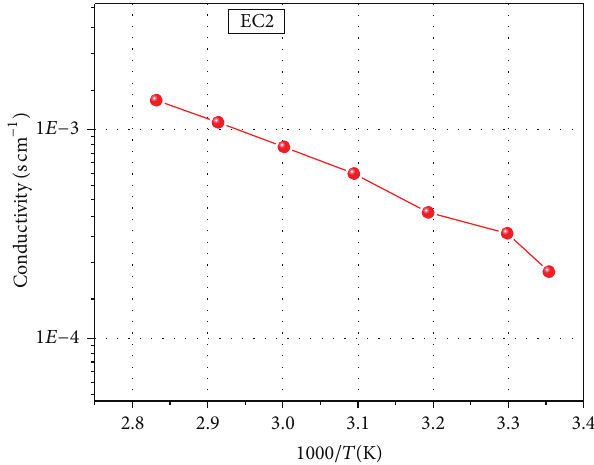
Figure 3: Ionic conductivity of BEMA/PEGMA polymer electrolyte versus